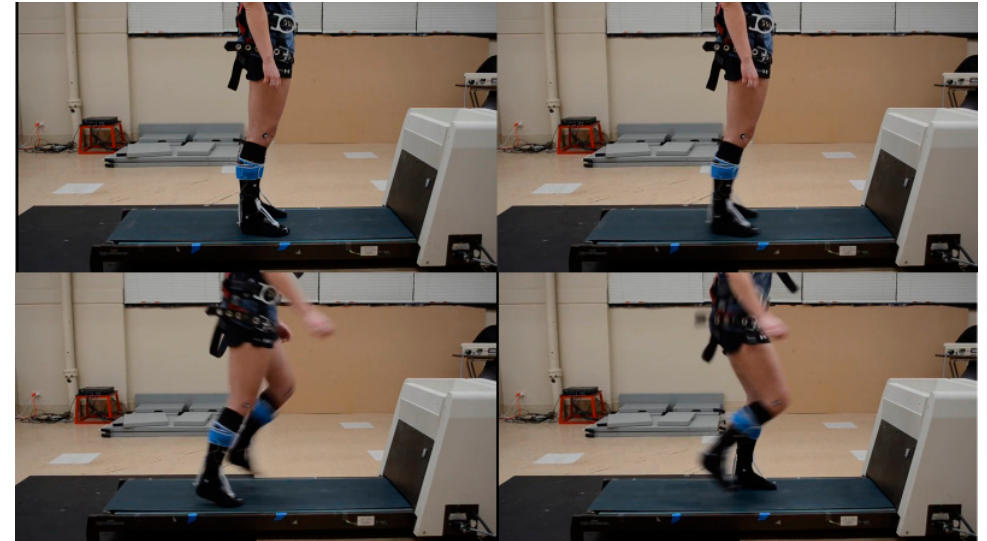
Figure 3. A sequence of an unexpected trip perturbation with wearable SRS and a motion capture marker system to assess fall detection.